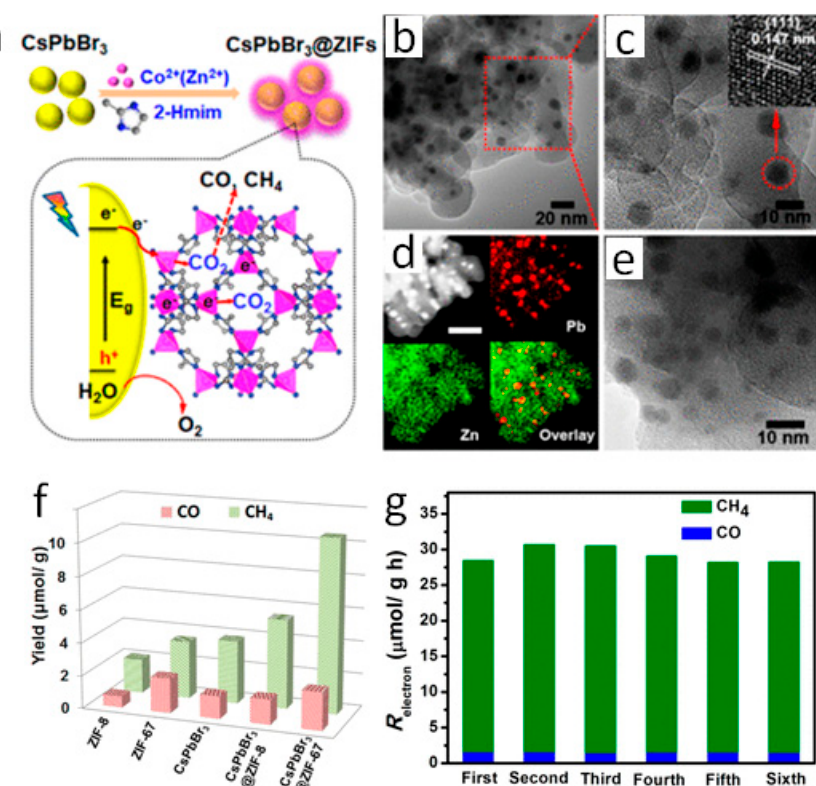
Figure 6. ( a ) Schematic illustration of synthesis and utilization of CsPbBr 3 /ZIFs for CO 2 reduction, ( b , c ) TEM of CsPbBr 3 @ZIF-8, ( d ) HAADF-STEM of CsPbBr 3 @ZIF-27, ( e ) TEM of CsPbBr 3 @ZIF-27, ( f ) CO 2 reduction results for pristine and composite, and ( g ) Stability test for CsPbBr 3 @ZIF-67. Reproduced from [85], with permission from American chemical society, 2018.